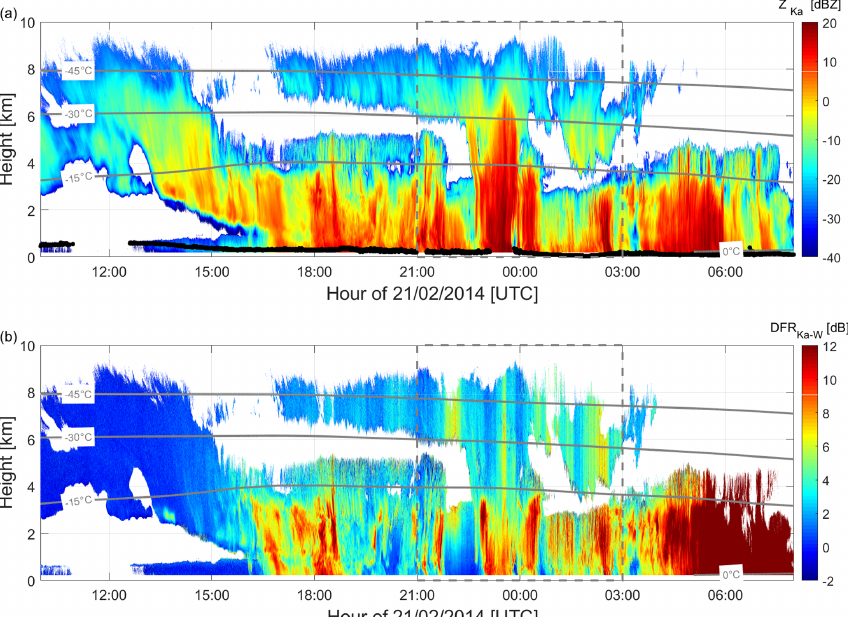
Figure 9. Time–height (UTC–km) plots of the (a) K a reflectivity with liquid cloud base detected by the co-located lidar as black points and (b) K a –W DFR observed at the Hyytiälä Forestry Field site on 21 February 2014. The gray lines show the − 45, − 30, − 15, and 0°C